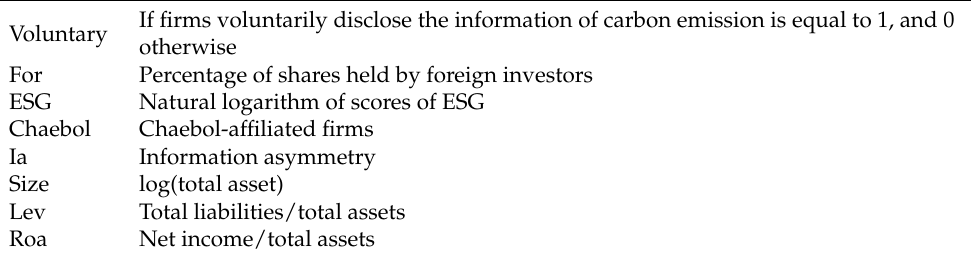
Table 1. Variable